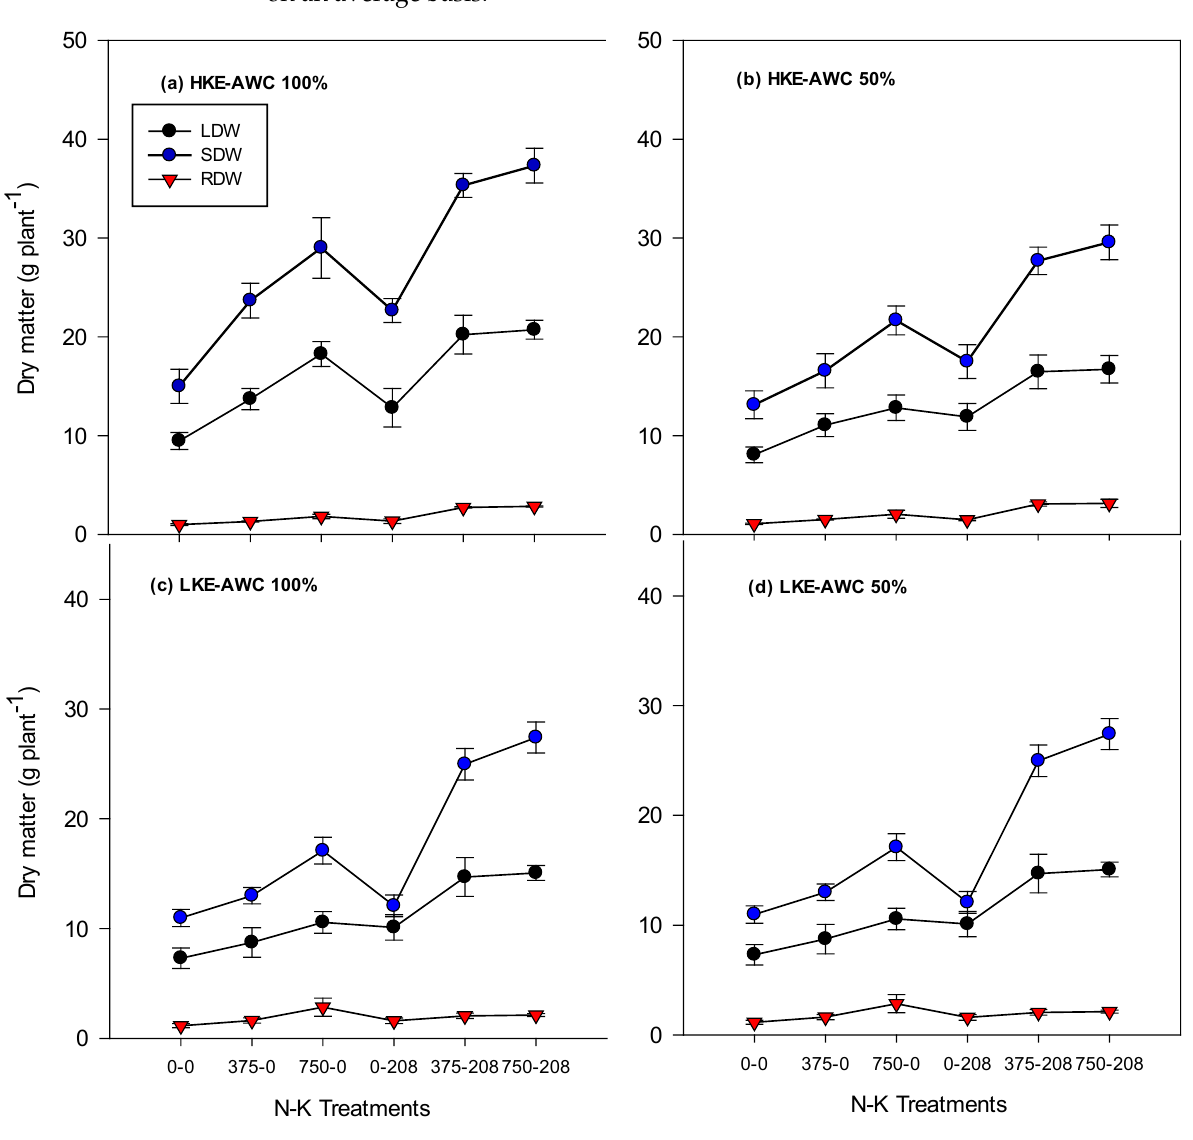
Figure 1. Variations in dry matter of different growth components i.e., HKE − AWC 100% ( a ), HKE − AWC 50% ( b ), LKE − AWC 100% ( c ), LKE − AWC 50% ( d ), as affected by N:K levels mg pot −1 under varied irrigation levels. Note: LDW—leaves dry weight; SDW—stalk dry weight; RDW—root dry weight.